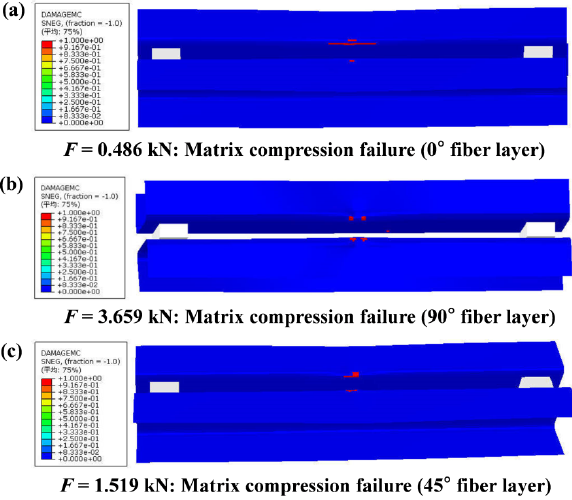
Figure 22: Matrix compression failure area distribution of fiber layers in final failure state. (a) SHCXL-A: 0 ∘ fiber layer; (b) SHCXL-A: 90 ∘ fiber layer; and (c) SHCXL-B: 45 ∘ fiber